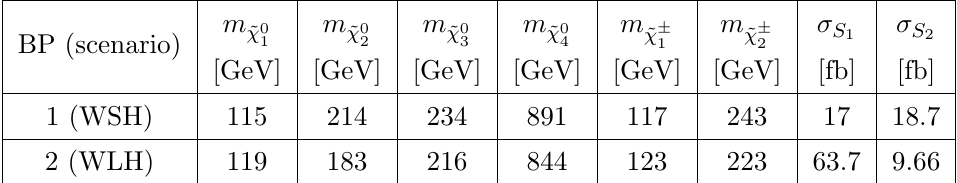
Table 2. Masses of the neutralinos and charginos as well as cross sections corresponding to the two signal processes for the BP with the lowest m in each scenario. e (cid:31) 0 1 chargino mass ranges of our interest, obtained from the public code PROSPINO-v2.1